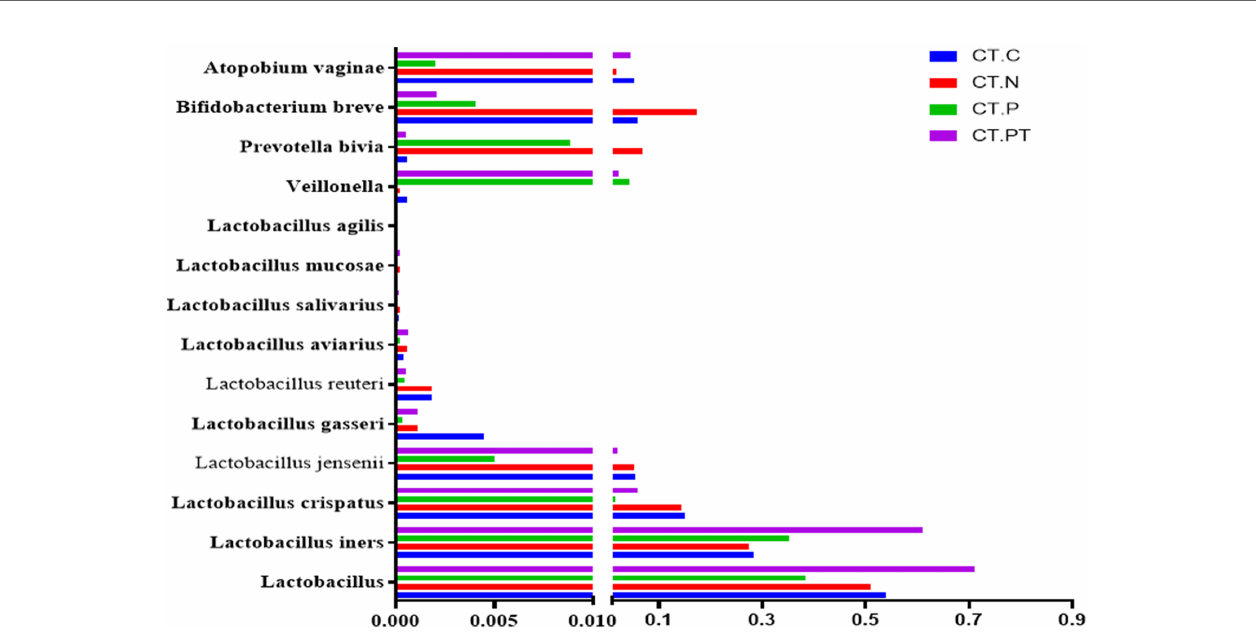
FIGURE 4 | Detection of dominant vaginal fl ora by speci fi c qRT-PCR. CT-C, women from the physical examination center (PEC) who were healthy and C. trachomatis - negative; CT-N, women who were infertile and C. trachomatis -negative from the assisted reproductive technology center (ART); CT-P, women who were infertile and C. trachomatis -positive from the ART; CT-PT, CT-P women post-treatment with